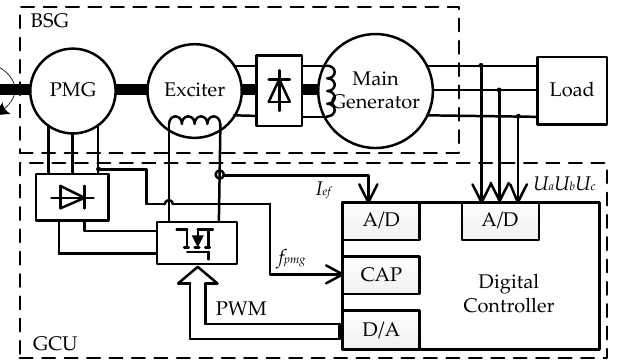
Figure 2. Main functional blocks of the brushless synchronous generator and generator control unit.